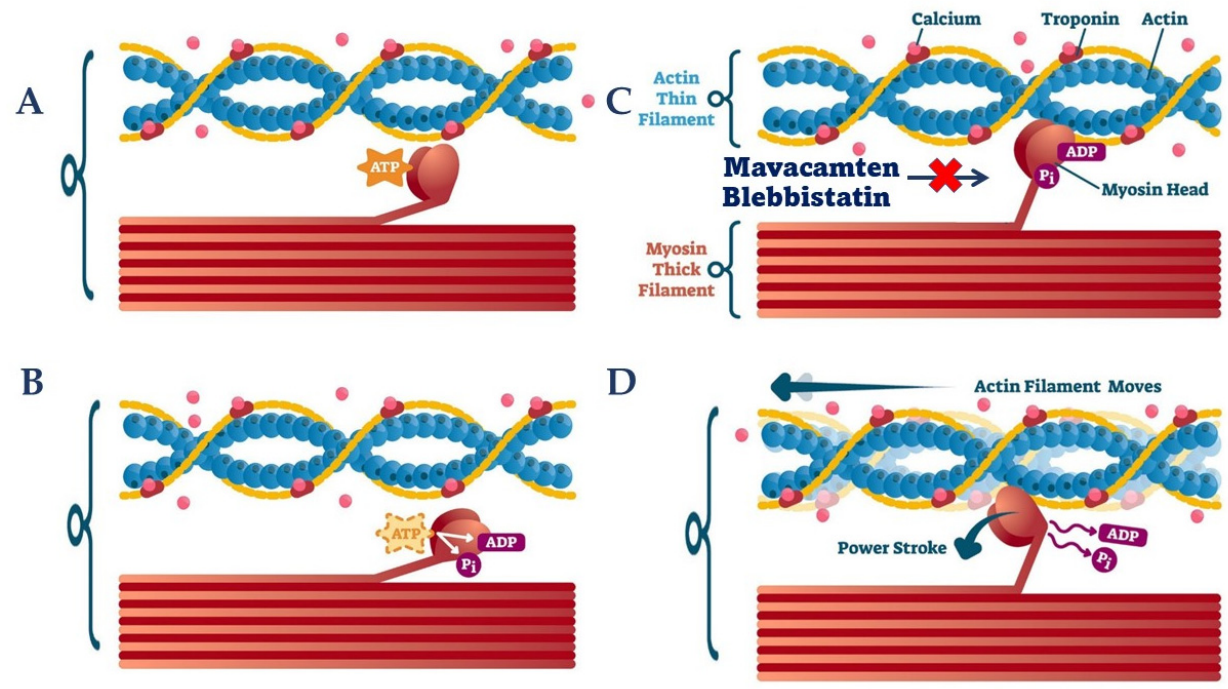
Figure 2. Myosin inhibitors—mechanisms of action. The chemomechanical cycle of myosin is demonstrated in panels ( A – D ). ( Panel A ): Binding of ATP to myosin head domain produces a decrease in actin affinity thus leading to actin dissociation (relaxed state). ( Panel B ): ATP hydrolysis leads to formation of ADP and Pi. ( Panel C ): Myosin-ADP-Pi complex binds to actin filaments. ( Panel D ): Conformational changes prompted by Pi release determine the power stroke, with ADP being released at the end of this phase and with a start of a new cycle. Mavacamten : (1) inhibits the release of Pi, (2) decreases the number of myosin head that bind to actin. Blebbistatin : inhibits Pi release after ATP hydrolysis. ADP = adenosine diphosphate; ATP = adenosine triphosphate; Pi = inorganic phosphate.